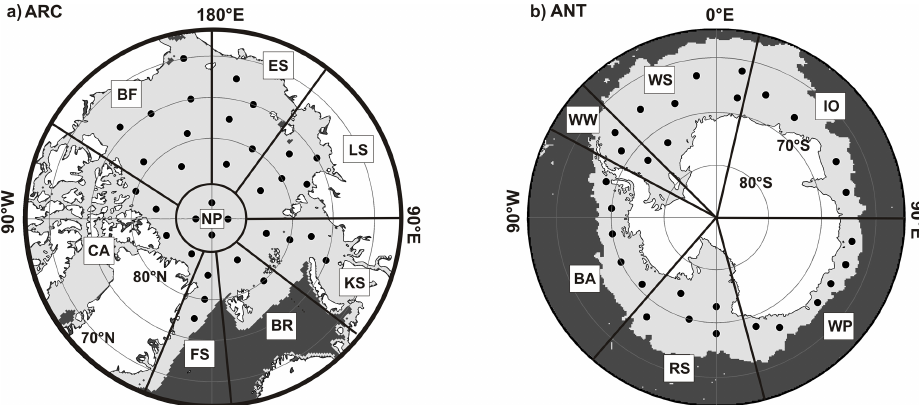
Fig. 1. Maps of the Arctic (a) and Antarctic (b) showing the regions referred to and the locations where atmospheric forcing data were extracted. The grey area indicates the average sea-ice extent for 1 June (Arctic) and 1 December (Antarctic), 2000–2009. Regions indicated are: Arctic: NP (North Pole), FS (Fram Strait), BR (Barents Sea), KS (Kara Sea), LS (Laptev Sea), ES (East Siberian Sea), BF (Beaufort Sea), CA (Canadian Arctic), Antarctic: WW (western Weddell Sea), WS (Weddell Sea), IO (Indian Ocean), WP (western Pacific), RS (Ross Sea), BA (Bellingshausen–Amundsen